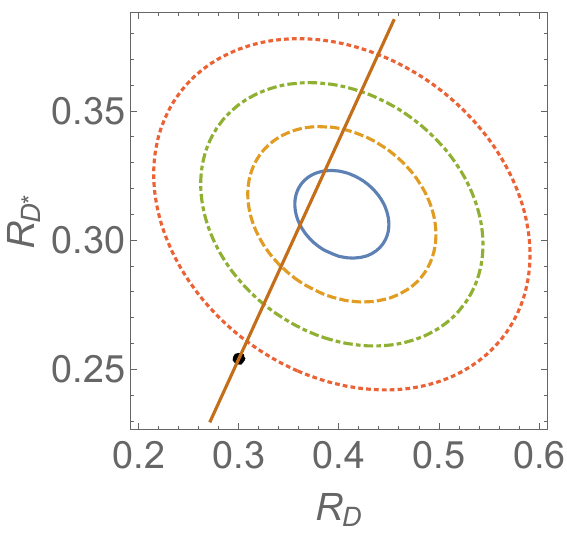
Figure 15 . Experimental region in the ( R D ; R D (cid:3) ) plane from 1 (cid:27) (inner ellipse){4 (cid:27) (outer el- lipse). The black spot is the Standard Model prediction. The straight line is where our model prediction